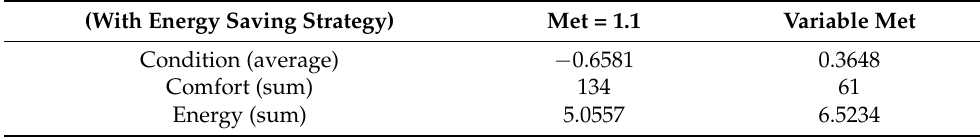
Table 9. Results of third and fourth